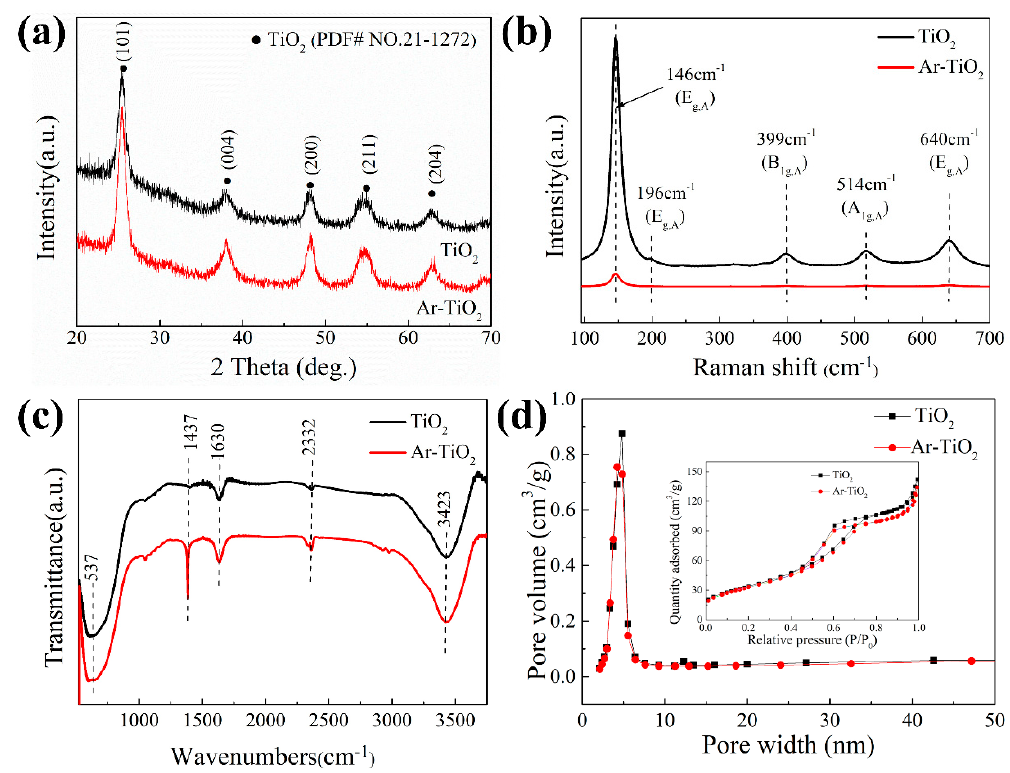
Figure 1. Spectra of ( a ) X-ray diffractometer (XRD) spectra, ( b ) Raman spectra, ( c ) Fourier transforms infrared spectra (FTIR) spectra and ( d ) BET spectra for the Ar-TiO 2 and pristine TiO 2 catalysts. Insert: the N 2 adsorption-desorption isotherms.